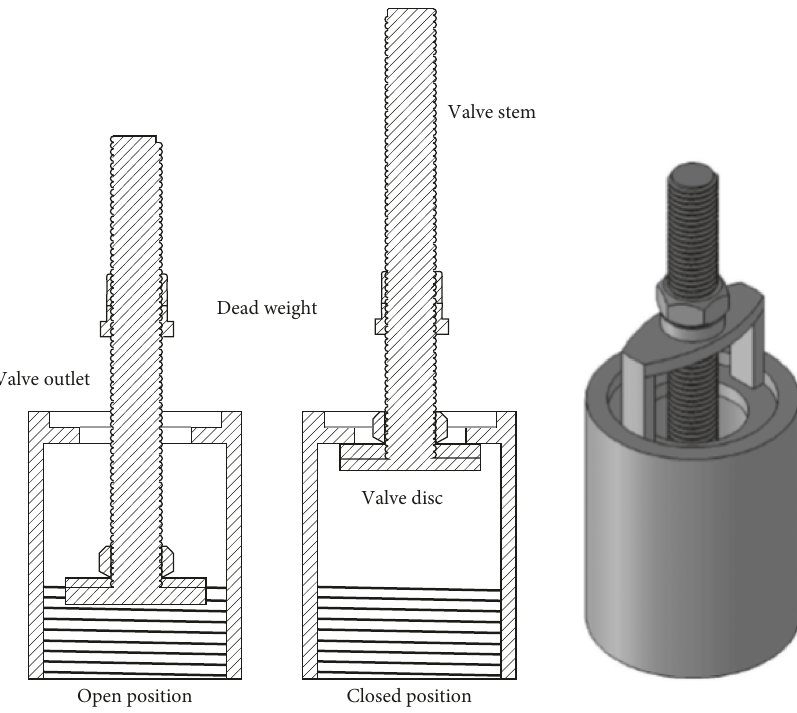
Figure 10: Drawings of a modified waste valve.